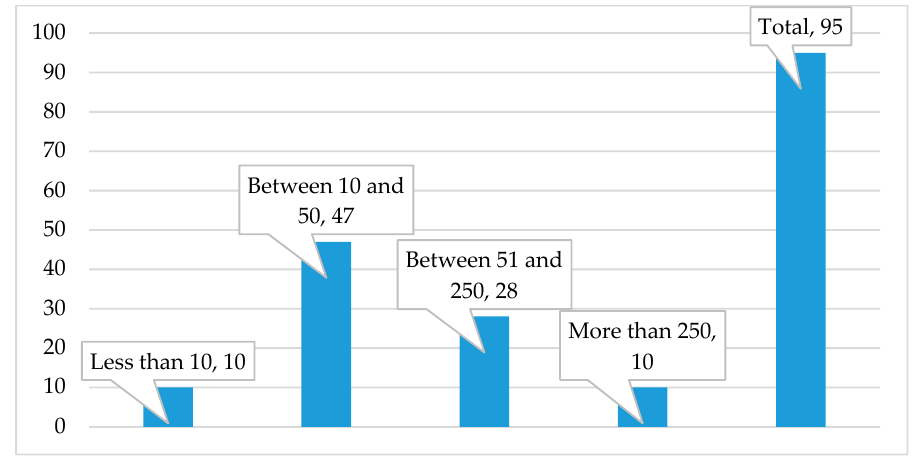
Figure 1. The size of the companies that are included in the survey.